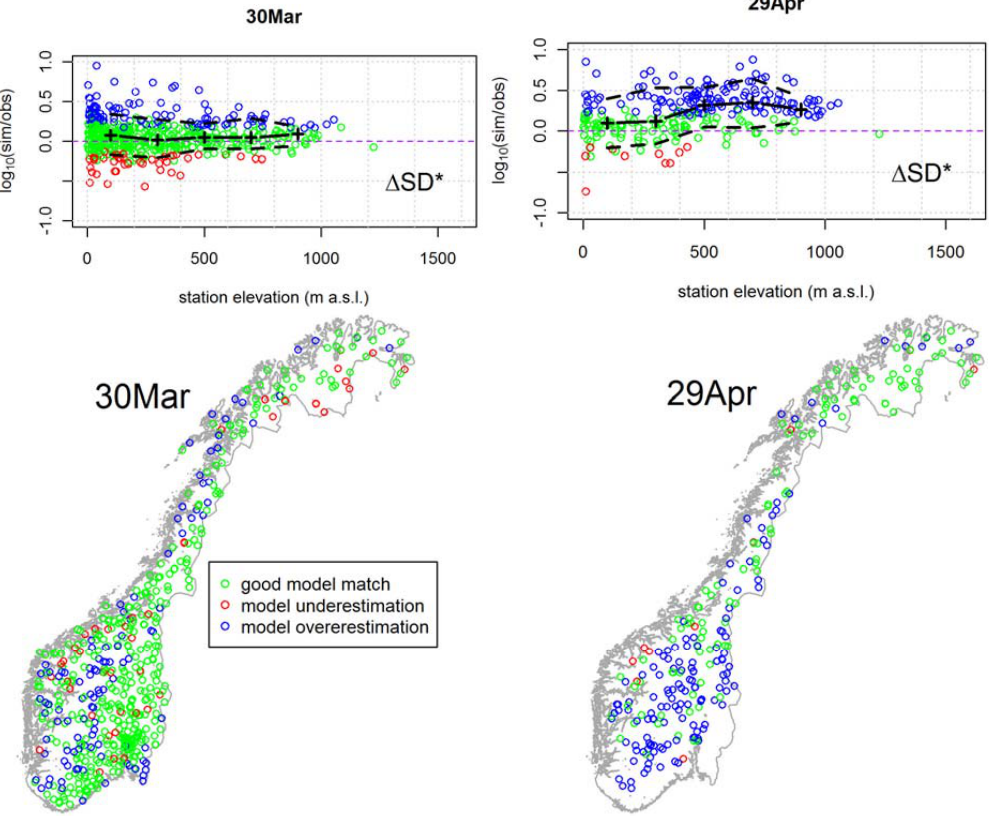
Fig. 3. Spatial distribution (with elevation and station position) of the station-wise mean log 10 -transformed ratio ( 1 SD ∗ ) between simulated and observed snow depth at two selected dates at met.no-stations from 1957–2011. The green, red and blue circles indicate stations with at least 15 years of observations, where the station-wise median 1 SD ∗ is not (green; “good match”), or is detected to be statistically significantly smaller (red; “underestimation”) or larger (blue; “overestimation”) than the threshold window of − 23 to +30% (corresponding to a factor larger than 1.3 deviation from a “perfect match”). A two-sided p-value < 0.05 is applied as the significance level. In the upper panel, the solid and dashed lines denote the median and the 10/90% percentiles of the station-wise means in each 200-m elevation bin, respectively. The total number of stations is 539 and 252 on 30 March and 29 April, respectively.